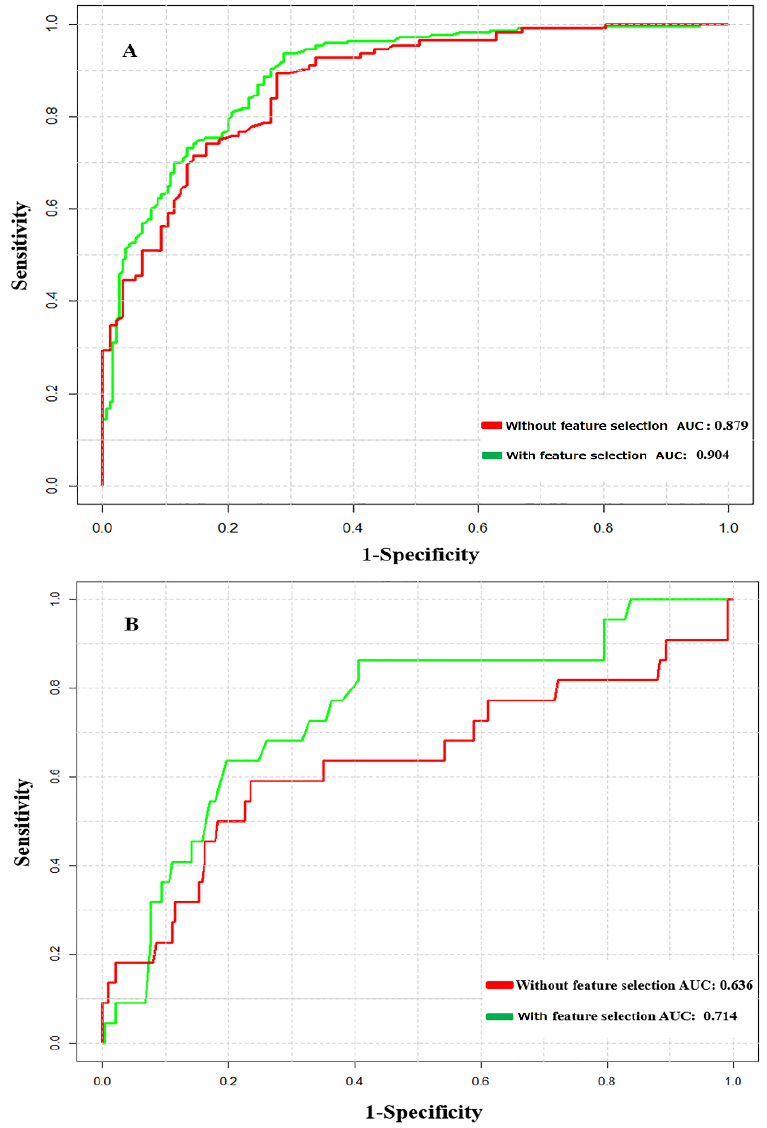
Figure 3. Performance comparison between without feature selection and with feature selection using receiver operating characteristics (ROC) curves: ( A ) performance based on 10-fold cross-validation (CV) test; ( B ) performance based on the independent dataset. AUC—area under an ROC curve.